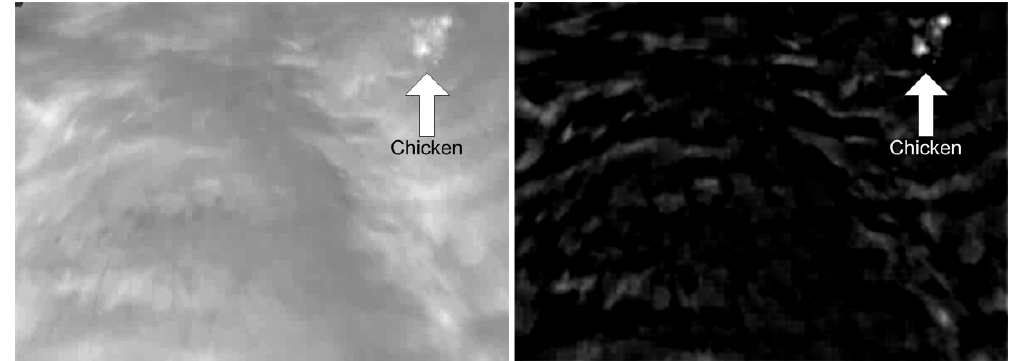
Figure 3. Illustration of the effect of pre-processing. Figure 3(left) is the original image of a chicken, and Figure 3(right) is the filtered image. The filtering enhances the chicken so it can be discriminated from the background.